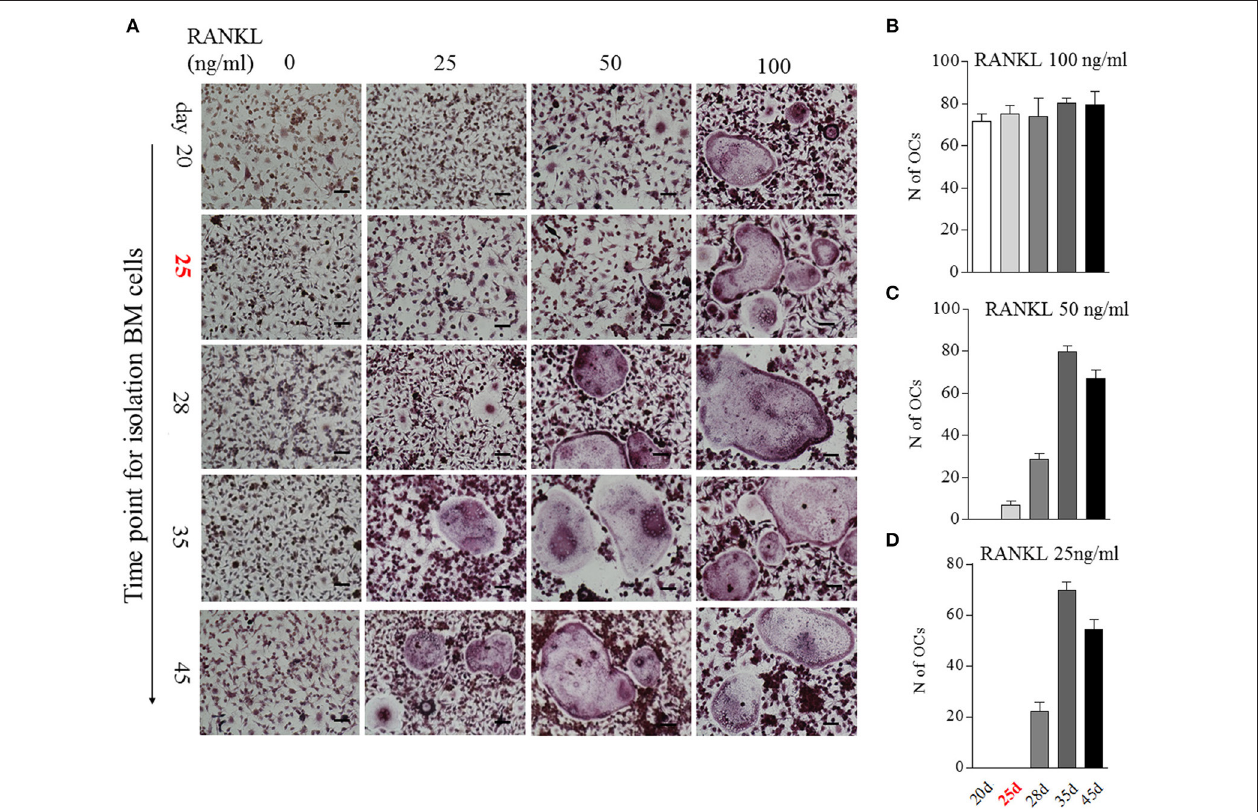
FIGURE 3 | The impact of BME on the differentiation bone marrow cells into OCs in vitro . (A) Bone marrow cells from different time points of CIA process were treated with C-MSF for 2 days and then were stimulated with a series of concentrations RANKL (0, 25, 50, and 100ng/ml) for 5d. The OCs formation was assayed by TRAP staining. (B–D) Graphs show the quantitation data of the effect of different dose of RANKL on the OCs formation in bone marrow cells from indicated time of CIA ( n = 5). All experiments were repeated three times. Scale bar, 100 µ